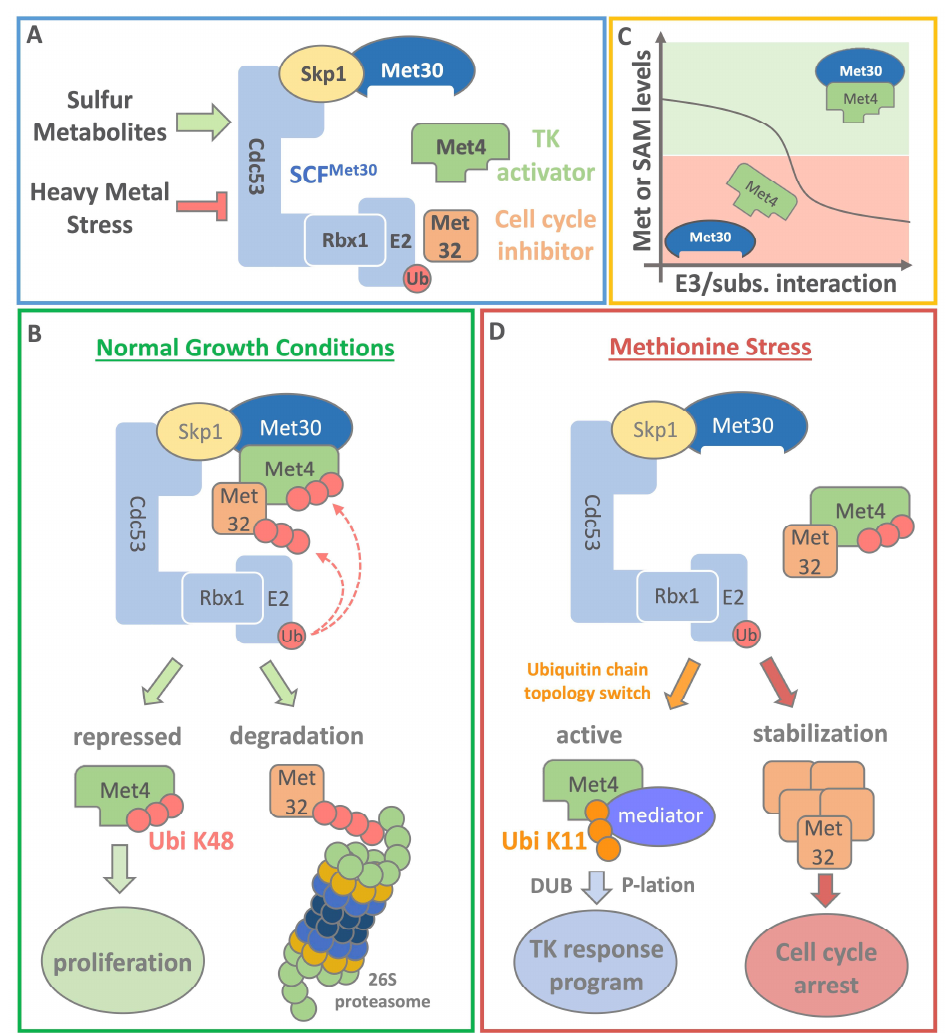
Figure 2. Methionine perception in yeast. ( A ) Blue box: The E3 ubiquitin ligase SCF Met30 is the center of the response to methionine starvation and heavy metal (cadmium) stress in yeast. The most critical substrates of the E3 ligase are the transcriptional activator Met4 and the cell cycle inhibitor Met32. Together they orchestrate the transcriptional response program during nutritional or heavy metal stress, however through profoundly distinct mechanisms. ( B ) Green box: Under normal growth conditions Met4 is ubiquitinylated by SCF Met30 . The attached K48 linked ubiquitin chain does not lead to the degradation of Met4. Instead, Met4 is kept in a stable and transcriptionally inactive state. Met4 is also a substrate receptor for the cell cycle inhibitor Met32. Met4 recruits Met32 to SCF Met30 to catalyze the ubiquitylation and subsequent degradation of the cell cycle inhibitor via the 26S proteasome pathway to ensure proliferation. ( C ) Yellow box: Under normal growth conditions, high levels of methionine and metabolites promote a stable Met4 complex with the E3 ligase via the F-box protein Met30. Low methionine or SAM levels lead to the dissociation of SCF Met30 from its substrate Met4. ( D ) Red box: Under methionine or SAM starvation conditions, a change in Met4 ubiquitin chain topology is induced from K48 to K11 linkage, allowing the association of the transcriptional coactivator complex mediator with Met4. After this initiation step, Met4 is deubiquitylated (DUB) and phosphorylated (P-lation). The now active Met4 drives starts a transcriptional (TK) response program that drives genes to restore SAM levels. Dissociation of Met4 in turn also blocks ubiquitylation of Met32, leading to its stabilization. Accumulation of Met32 triggers a cell cycle arrest. Once sulfur containing metabolites are restored binding between SCF Met30 and its substrates is promoted. Met4 and Met32 get re-ubiquitylated resulting in transcriptional inactivation and degradation respectively. The cell cycle arrest is terminated and proliferation can progress.